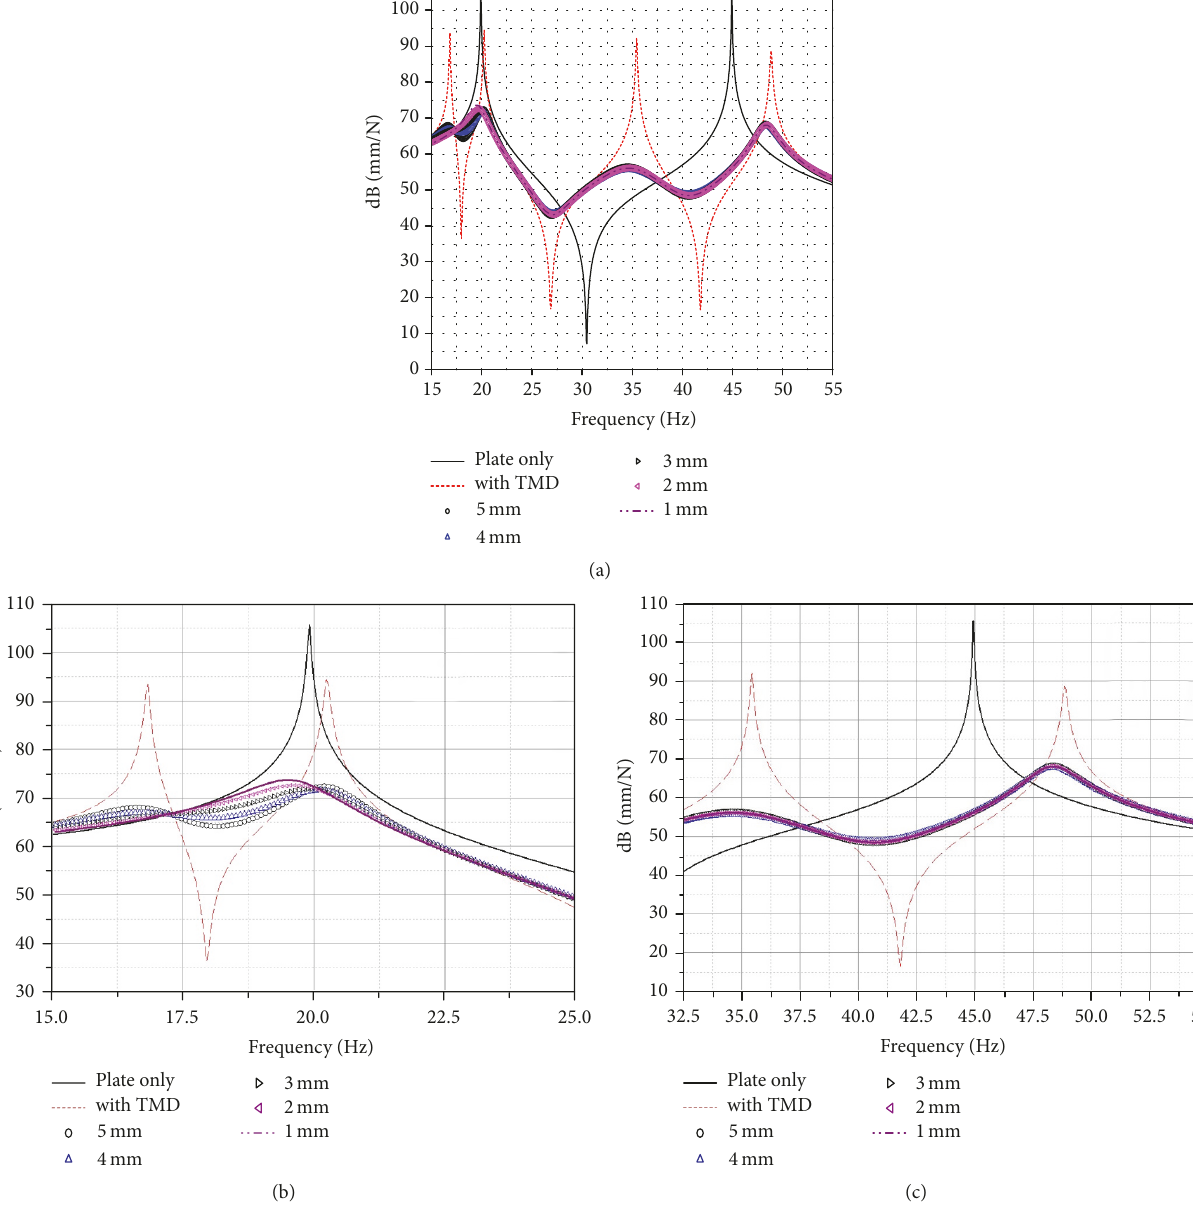
Figure 16: Effect of the gap size of the primary structure: (a) with the mTMD, (b) with the mTMD in bending mode, and (c) with the mTMD in torsion mode.